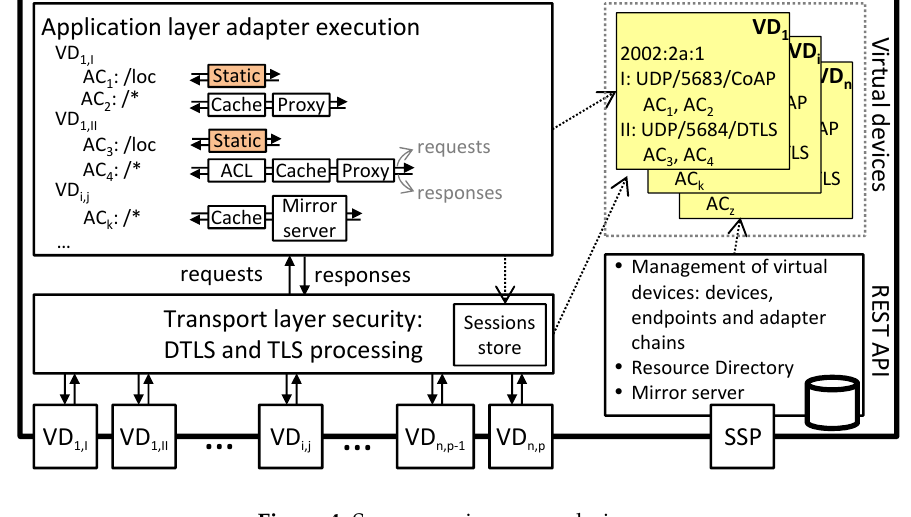
Figure 4. Secure service proxy: